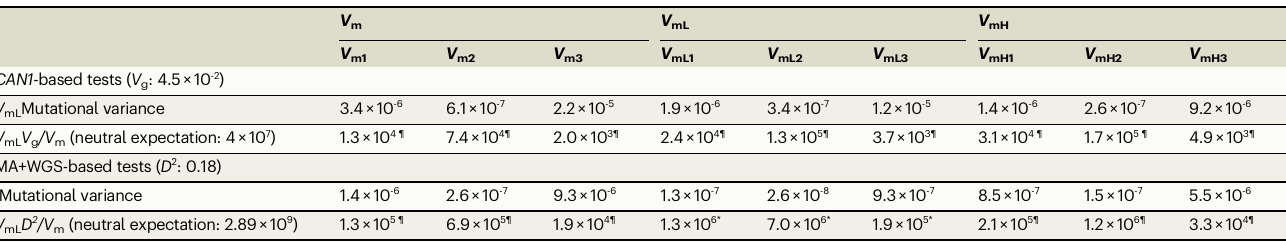
Table 1 | Test of stabilizing selection of the mutation rate in